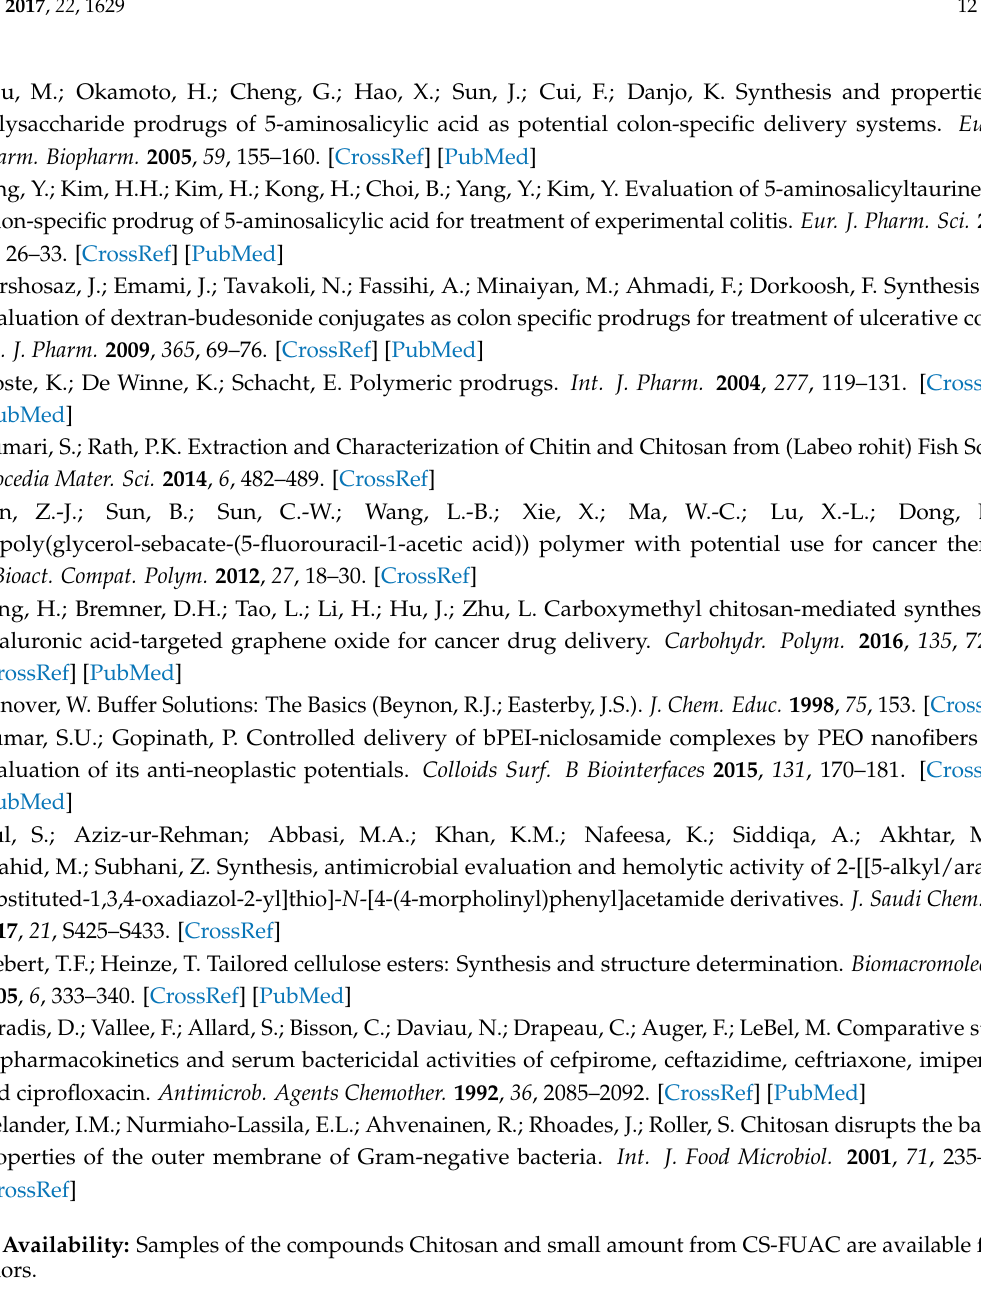
Sample Availability: Samples of the compounds Chitosan and small amount from CS-FUAC are available from the